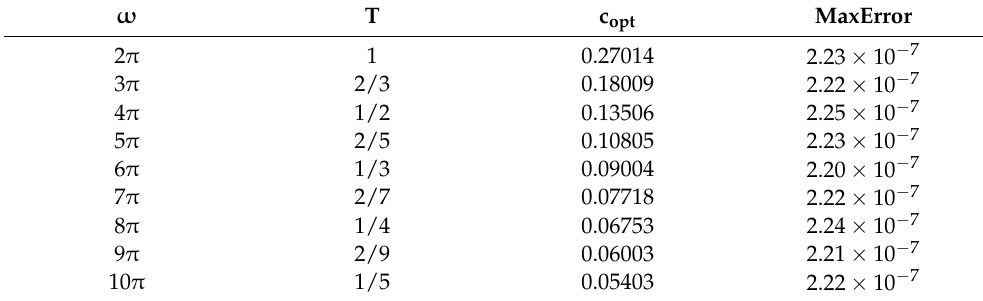
Table 7. Partial results of ω = k π ( k = 2, . . . ,10 )